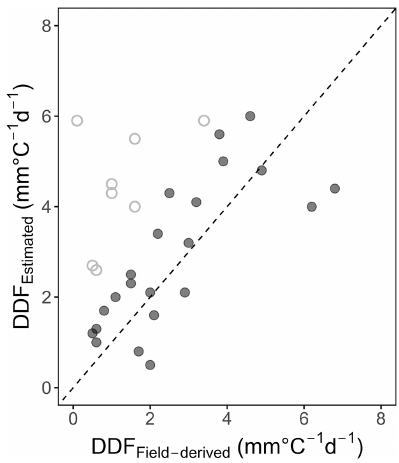
Figure 11. Comparison of field-derived vs. estimated (energy-flux- based) 10d DDF for the Brunnenkopfhütte test site (period: Novem- ber 2016–May 2021) – hollow points represent DDFs during peri- ods with new snow events (new snow: precipitation ≥ 5mmd − 1